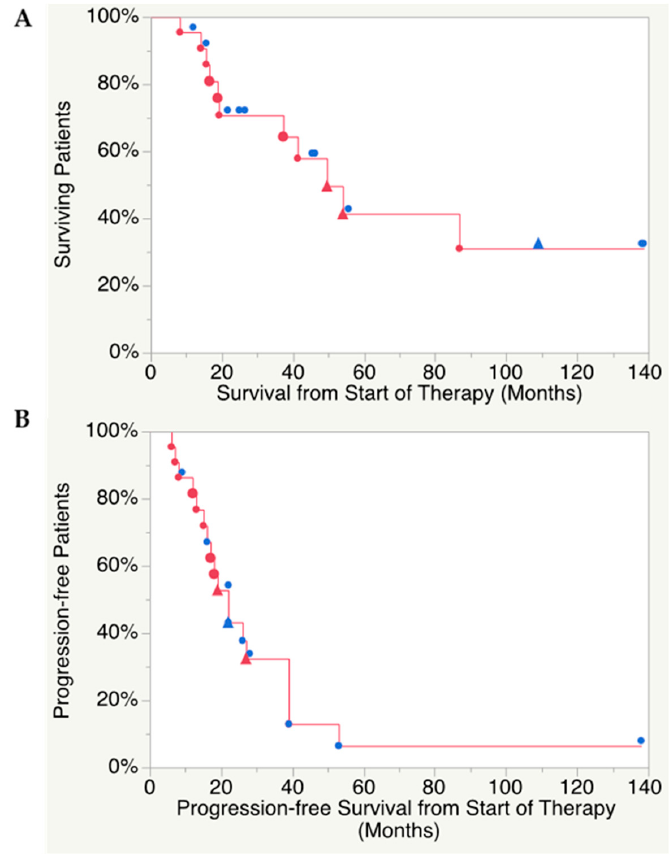
Figure 1. ( A ) Kaplan–Meier analysis of overall survival, median 49.6 (range 8.2–139) months and ( B ) progression-free survival, median 21.6 (range 6.7–138) months. Blue symbols, patient alive; red symbols, patient deceased. Triangles, patient received salvage therapy.